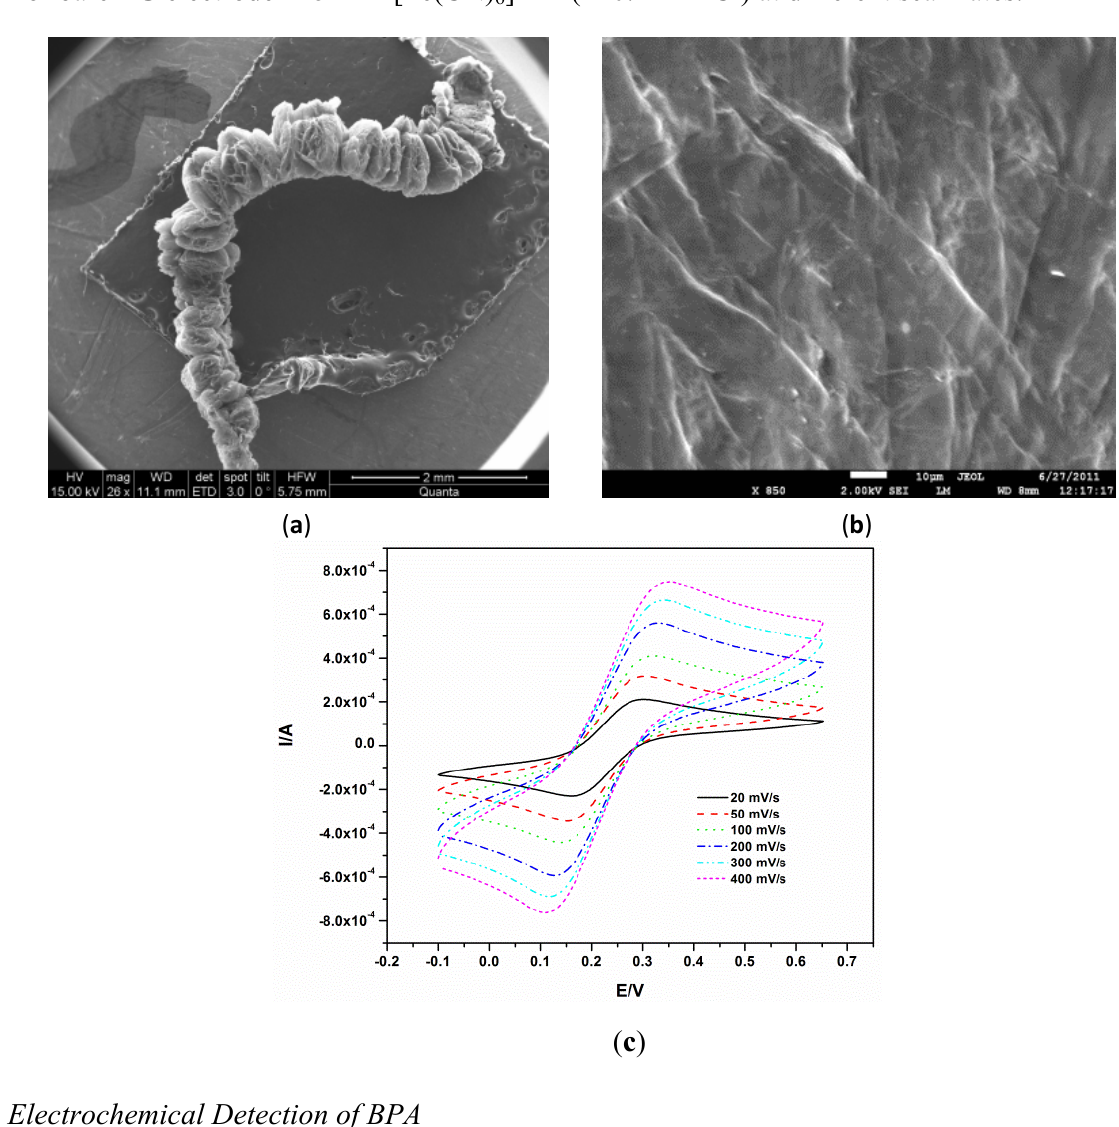
Figure 1. ( a ) SEM image EG; ( b ) SEM image of compressed EG and ( c ) Cyclic voltammetry of bare EG electrode in 5 mM [Fe(CN) ] 3 − /4 − (in 0.1 M KCl) at different scan 6